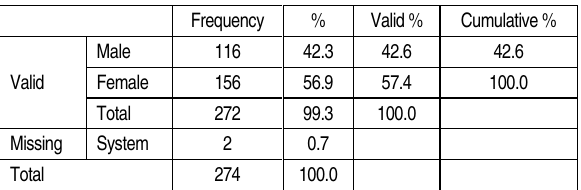
Table 3. Gender of respondents